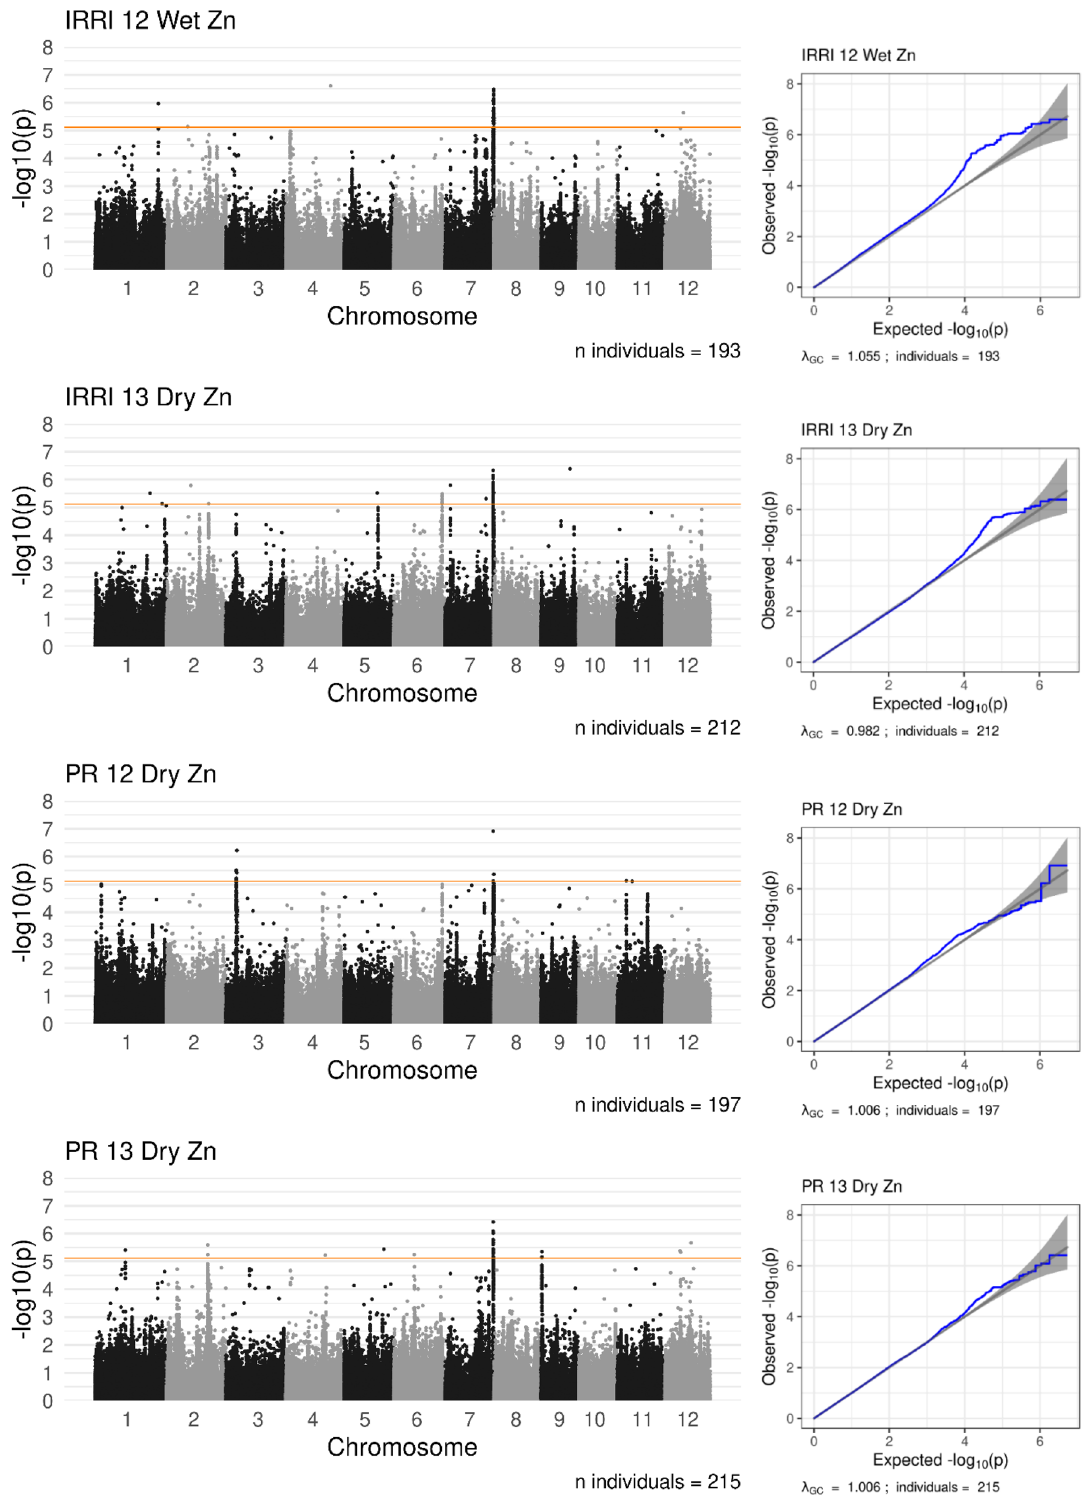
Figure 3. Manhattan plots (left) and QQ plots (right) showing results of association analysis for zinc concentration in 2012 IRRI wet season (IRRI 12 Wet Zn), 2013 IRRI dry season (IRRI 13 Dry Zn), 2012 PhilRice dry season (PR 12 Dry Zn) and 2013 PhilRice dry season (PR 12 Dry Zn). The orange line indicates a significance threshold of − log 10 (p) >